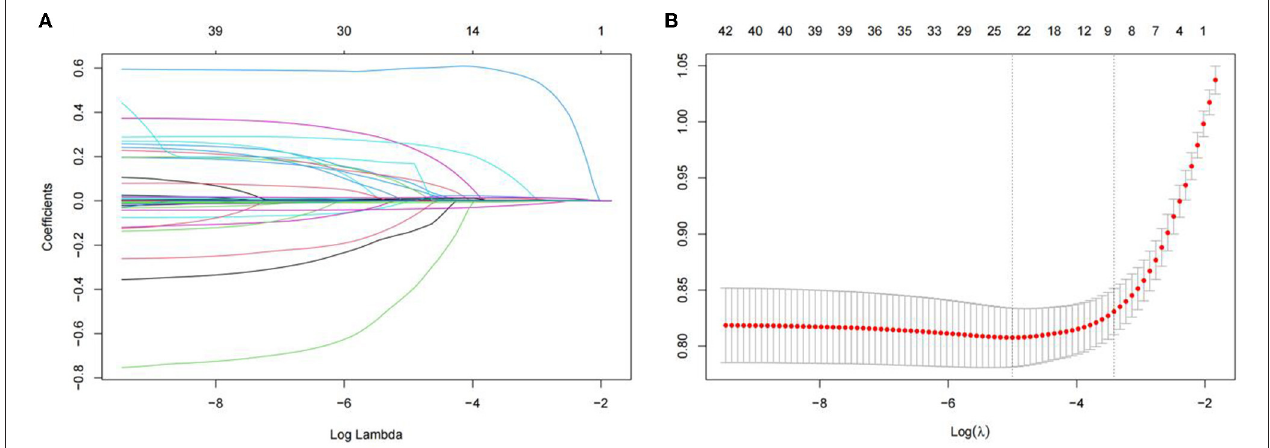
FIGURE 1 | Demographic and clinical feature selection using the LASSO binary logistic regression model. (A) The selection of the best parameter (lambda) in the LASSO model uses five-fold cross-validation with the lowest standard. The relationship curve between partial likelihood deviation (binomial deviation) and log(lambda)was plotted. Dotted vertical lines were drawn at the optimal values by using the minimum criteria and the 1 SE of the minimum criteria (the 1-SE criteria). (B) LASSO coefficient profiles of the 11 features. A coefficient profile plot was produced against the log (lambda) sequence. Vertical line was drawn at the value selected using five-foldcross-validation. LASSO, least absolute shrinkage and selection operator; SE, standard error.